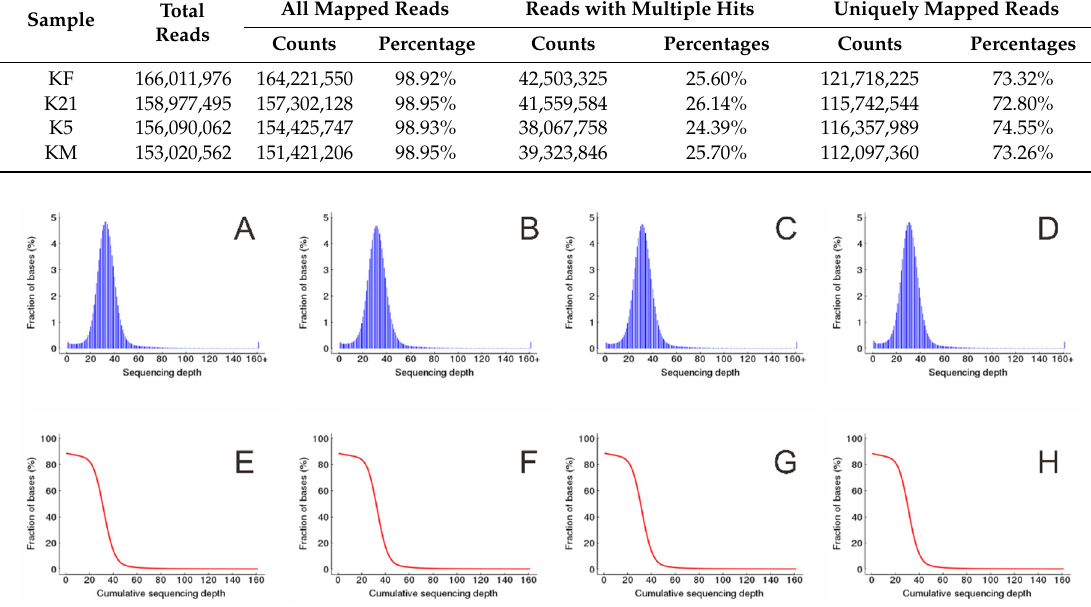
Figure 2. Coverage depth of reference contributed by clean reads. ( A – D ) Distribution of coverage depth of reference contributed by KF, K21, K5, and KM, respectively, and ( E – H ) cumulative distribution of coverage depth of reference contributed by KF, K21, K5, and KM, respectively. Table 2. Summary of reads mapped to reference genome.